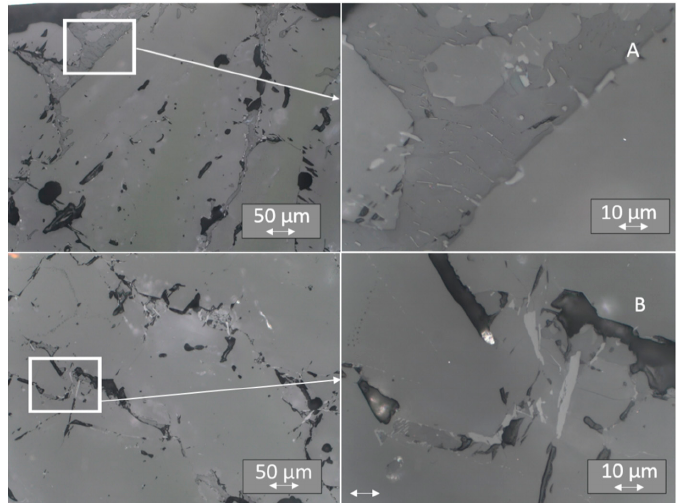
Figure 12. Microstructure of LMP doped with 0.8-mol% Tb. Top panels ( A )—sample No. 2 at a magnification of 200 × (on the left) and 1000 × (on the right); bottom panels ( B )—sample No. 11 at a magnification as above. The inset on the left has been further magnified on the right.